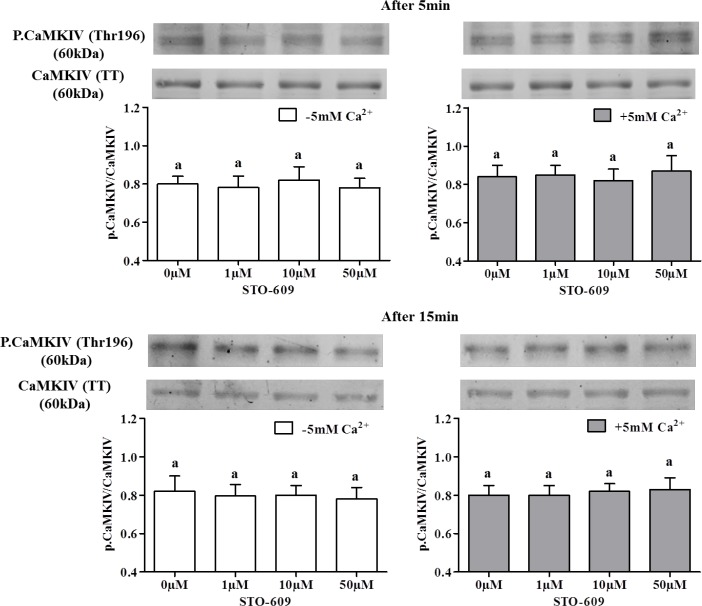
Effects of STO-609 on the CaMKIV phosphorylation in chicken sperm.Sperm incubated at 35°C in the –5mM Ca2+ or +5mM Ca2+ medium with or without CaMKKs inhibitor STO-609 (0; 1; 10; 50 μM) at 5 min and 15 min. The control (Ctrl): sperm incubated with or without Ca2+ in the absence of STO-609. Proteins from sperm lysates were analyzed by western-blotting using anti-phospho-Thr196-CaMKIV or anti-CaMKIV as the primary antibody. Bands for phospho-Thr196-CaMKIV were detected at 60kDa (top lanes). Total CaMKIV (60kDa) was used as loading control (bottom lanes) and the phosphorylated protein CaMKIV (Thr196)/total CaMKIV ratio is shown at the bottom. Results express the mean ± SEM of the mean from 4 different experiments. There were no significant differences between treatments (P<0.05).